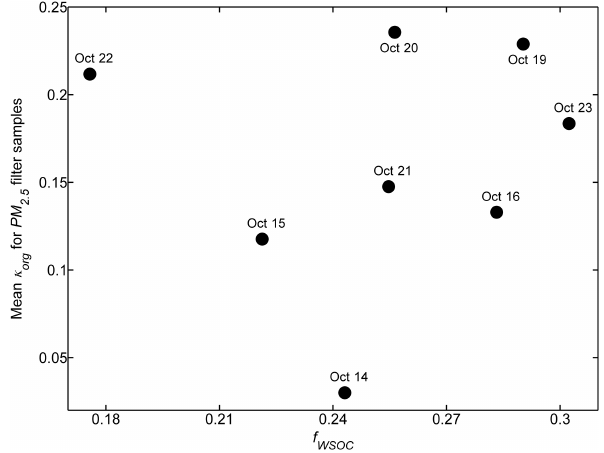
Figure 8. Correlation between the mean κ of organics ( κ org , with 10.0% EC mass fraction considered in the κ calculation) and the mean WSOC fraction ( f WSOC ) of PM 2 . 5 filter